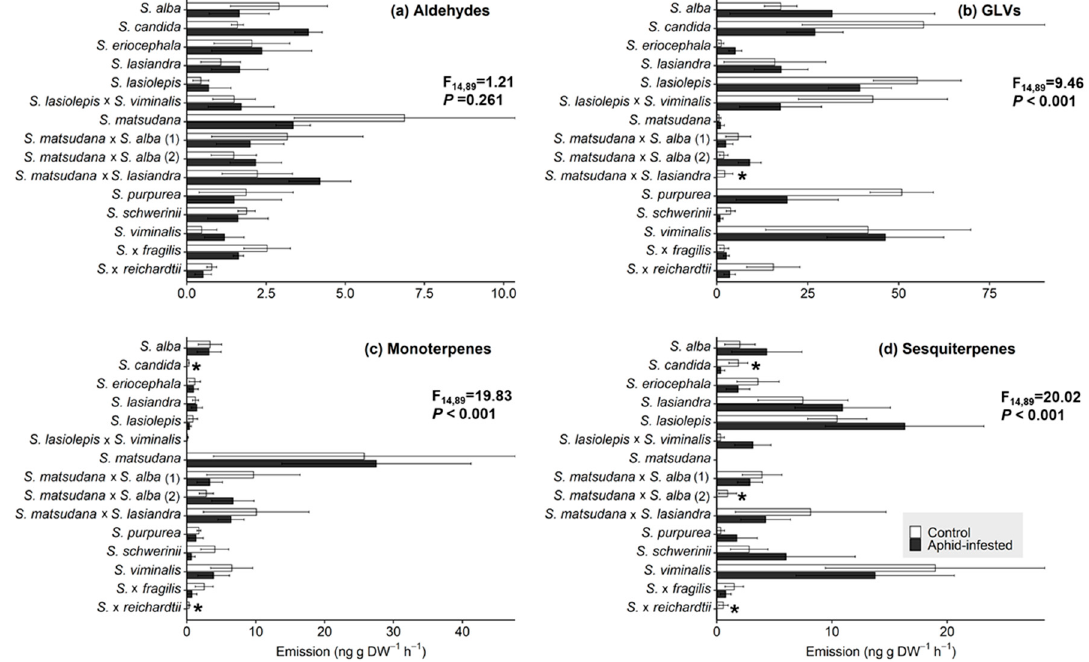
Figure 5. Total emissions of ( a ) aldehydes, ( b ) GLVs, ( c ) monoterpenes and ( d ) sesquiterpenes by the fifteen willow species and hybrids in the control and aphid-infested treatments. Values and error bars indicate means ± SE. Asterisks indicate significant differences between the treatments within each species/hybrid, Tukey’s HSD test, α = 0.05. Detailed multiple comparisons can be seen in Table S3.